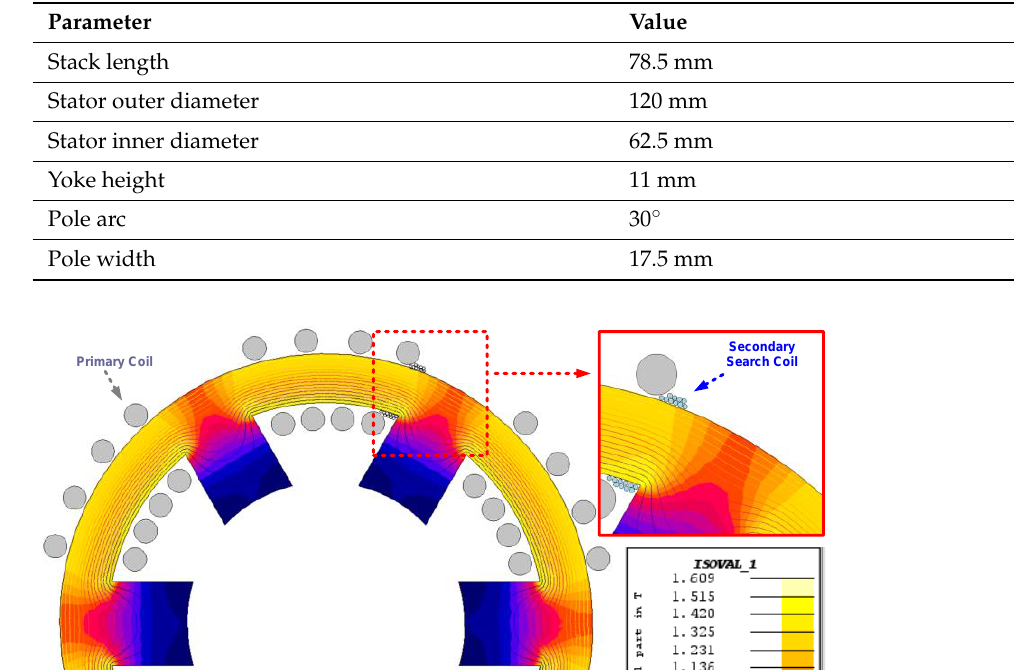
Table 1. SRM machine stator dimensions.